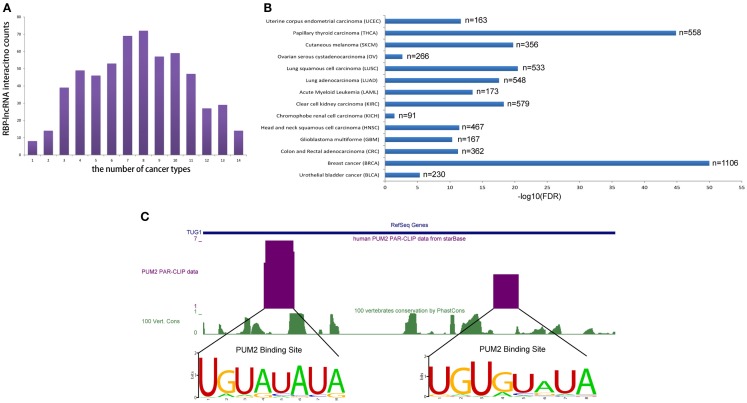
RBP–lncRNA interactions are supported by co-expression analysis in 14 types of cancers. (A) Histograms show RBP–lncRNA interactions with expression association (Pearson correlation, p < 0.05) in at least one cancer type. (B) The expression levels of PUM2 and TUG1 are positively correlated (p < 0.05) in all 14 cancers. (C) The PUM2 binding sites on TUG1 are inferred from PAR-CLIP data, and the consensus recognition motif UGURUAUA are conserved in mammals.